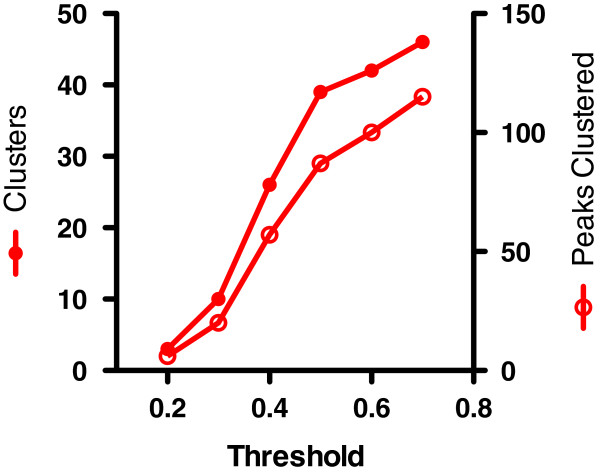
Number of technical clusters and clustered peaks from unfractionated CSF dataset. The Technical Clustering software was applied to a dataset of 247 peaks from 45 unfractionated CSF samples in a biomarker discovery dataset at the indicated variance threshold. The number of technical clusters (solid red circles) and number of peaks clustered (open red circles) are plotted.